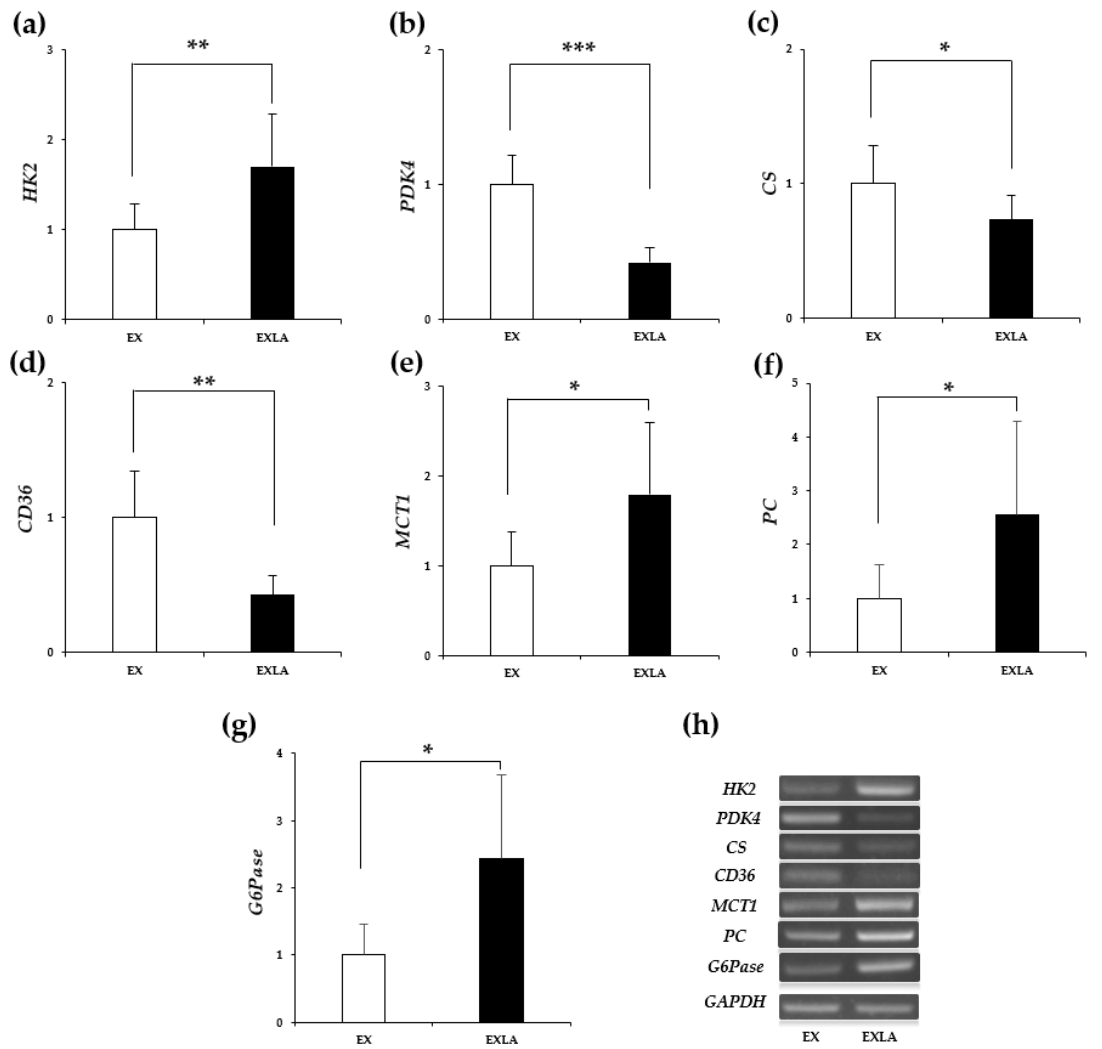
Figure 7. Expression of energy metabolism-related mRNAs in the gastrocnemius muscle: ( a – g ) quantification of HK2 , PDK4 , CS, CD36 , MCT1, PC, and G6Pase mRNA levels, respectively; ( h ) representative gene expression images. HK2 , hexokinase 2; PDK4 , pyruvate dehydrogenase kinase 4; CS , citrate synthase; CD36 , cluster of differentiation 36; MCT1 , monocarboxylate transporter 1; PC , pyruvate carboxylase; G6Pase , glucose 6-phosphatase; GAPDH , glyceraldehyde 3-phosphate dehydrogenase; EX, exercise control group; EXLA, exercise with lactate intake group. GAPDH was used for the normalization of the target mRNA expression. Values represent the mean ± standard deviation ( n = 8). * p < 0.05; ** p < 0.01; *** p < 0.001.